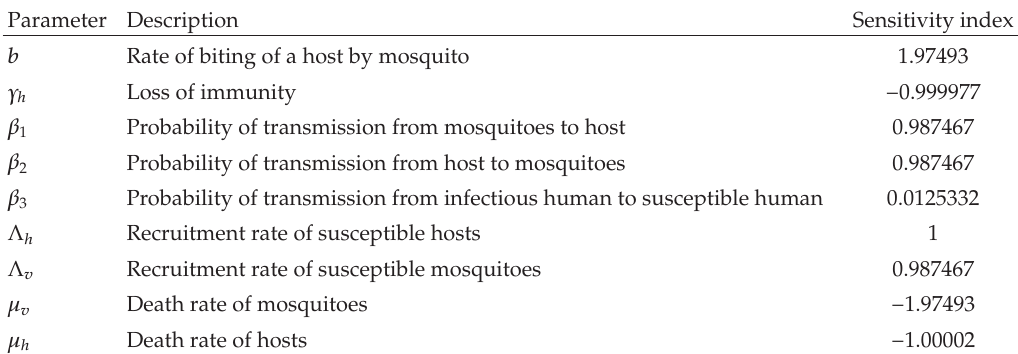
Table 2: Sensitivity indices of R 0 to parameters for the model, evaluated at the parameter values given in Table